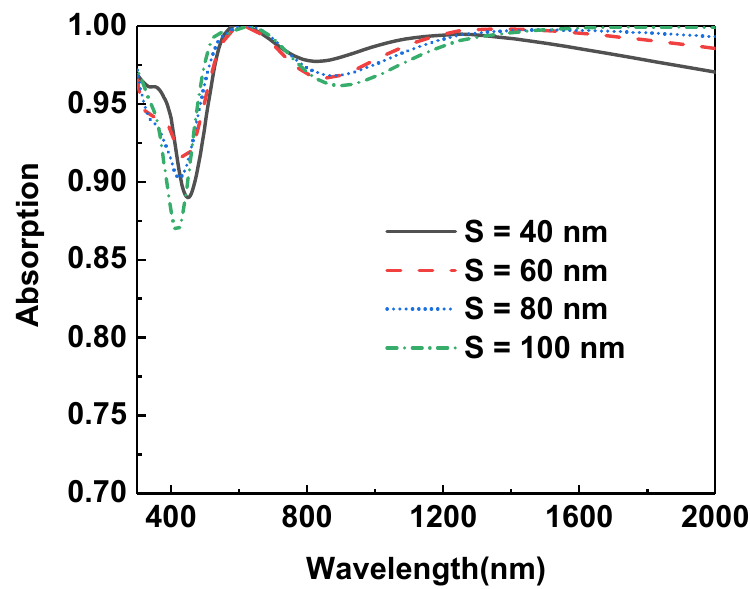
Figure 7. Comparison of light absorption of the absorbers with different SiO 2 thicknesses in the bottom multilayer.